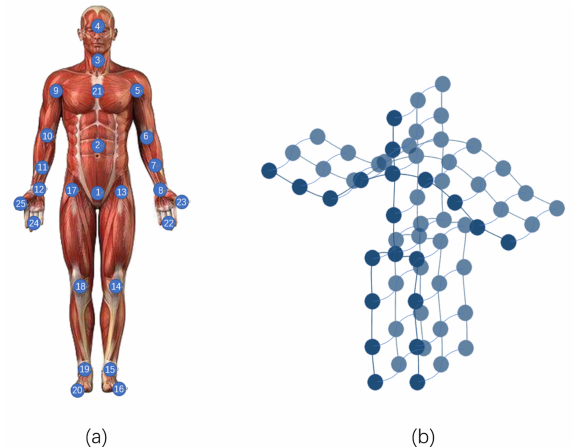
Figure 1. ( a ) The joint labeling of the NTU-RGBD and NTU-RGBD-120 datasets; the 21st node is defined as the gravity center of human. ( b ) The spatio-temporal graph used in ST-GCN